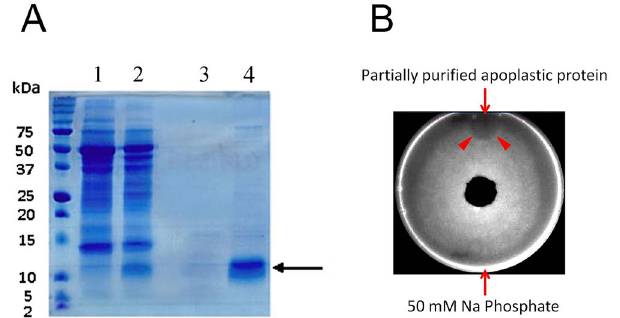
Figure 3. Partial purification of Efe -AfpA from apoplastic proteins and its activity against the dollar spot fungus. ( A ) SDS-PAGE analysis of partially purified Efe -AfpA from apoplastic proteins. Lane 1, total apoplastic proteins from leaves of endophyte-free plants; Lane 2, total apoplastic proteins from leaves of endophyte- infected plants; Lane 3, unbound fraction from the HiTrap phenyl HP column; Lane 4, desalted proteins eluted from the HiTrap phenyl HP column with 50 mM NaPO 4 , 1 M (NH 4 ) 2 SO 4 (pH 7.0). Arrow indicates band cut for protein sequencing. ( B ) Plate assay of antifungal activity of the partially purified Efe -AfpA from apoplastic proteins against the dollar spot fungus. A plug of the dollar spot fungus was placed in the center of the plate and 30 μ L (1 μ g μ L − 1 ) of Efe -AfpA and 50 mM NaPO 4 were spotted at opposite ends of the plate. Arrow indicates region of growth inhibition at position of Efe -AfpA application.